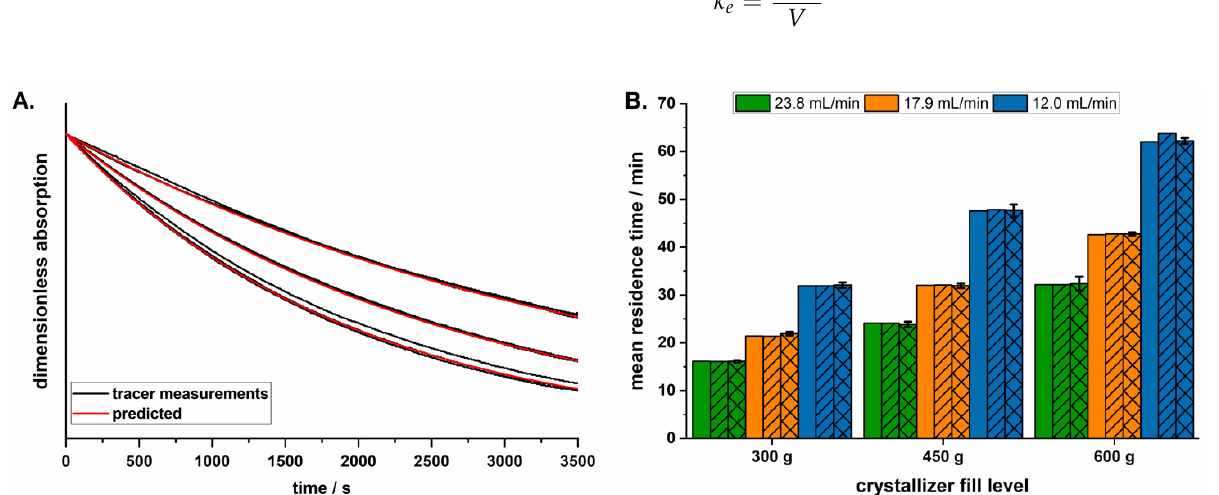
Figure 3. ( A ). Example of actual single tracer measurements curves ( n = 3 at each pump rate) at a fill level of 600 g with the predicted curves; ( B ). predicted MRTs at t = 0 min, using different equations (without pattern: Equation (2), dash: Equation (3)) compared to measured MRTs (crossed pattern, mean ± s, n = 3).